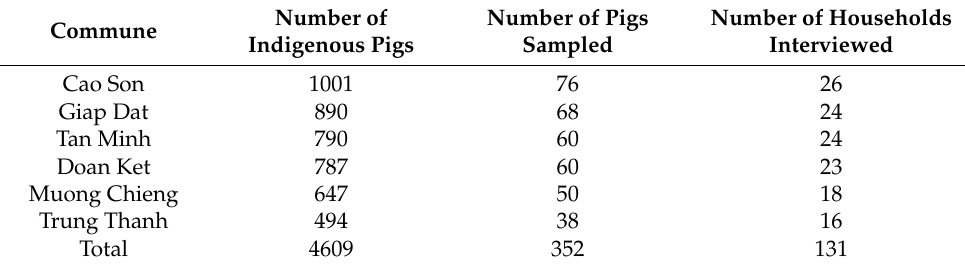
Table 1. NumberofsampledpigsandinterviewedhouseholdsinDaBacdistrict,HoaBinhprovince,Vietnam.